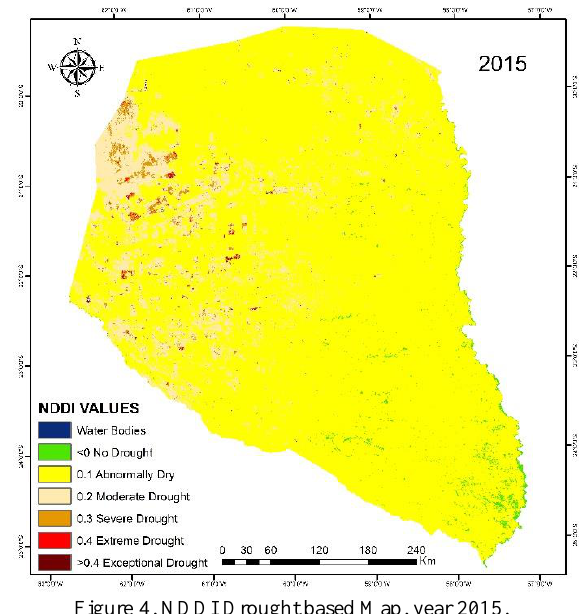
Figure 4. NDDI Drought based Map, year 2015.